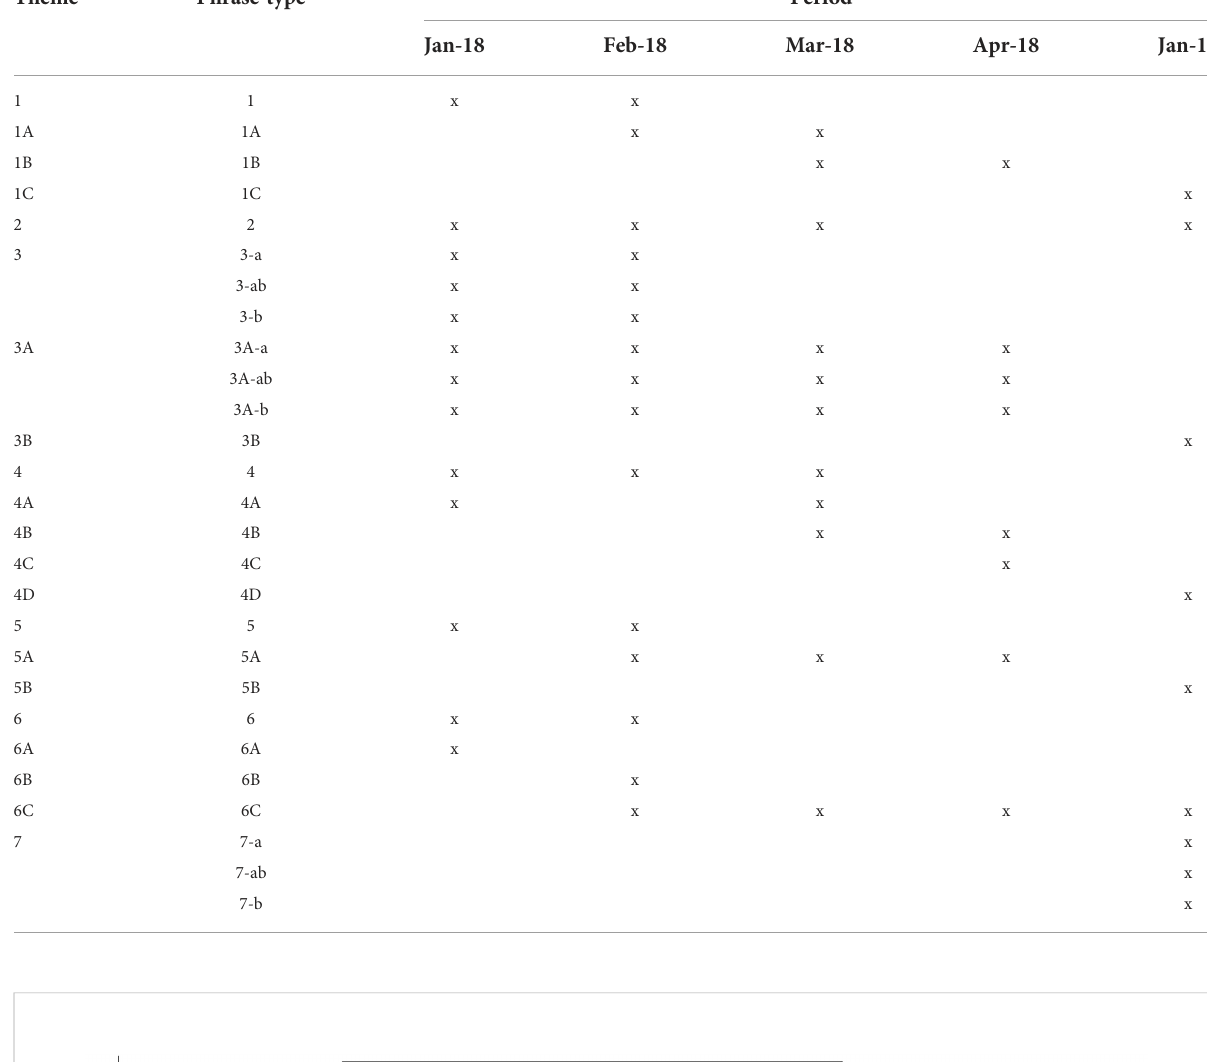
TABLE 2 Theme occurrence throughout the study period (January 2018 - January 2019).